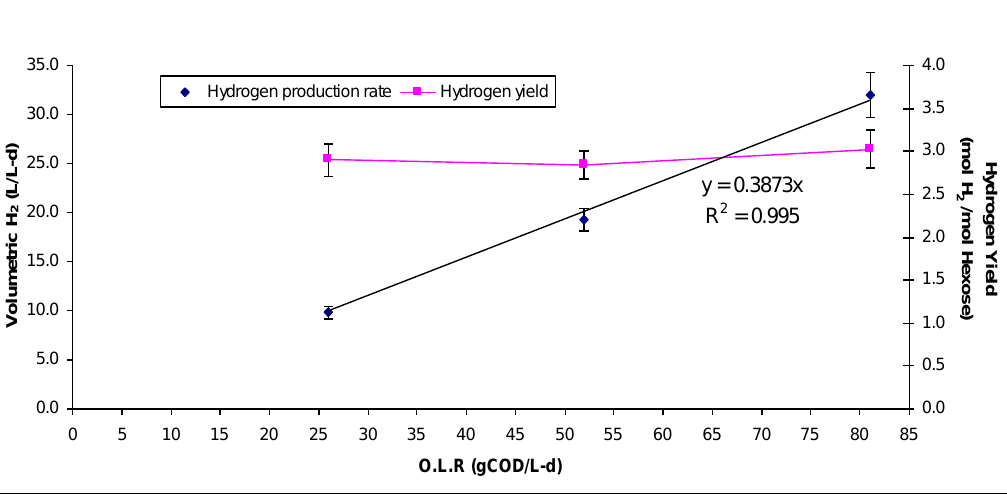
Figure 3. Relationship between hydrogen production rate and biomass yield versus